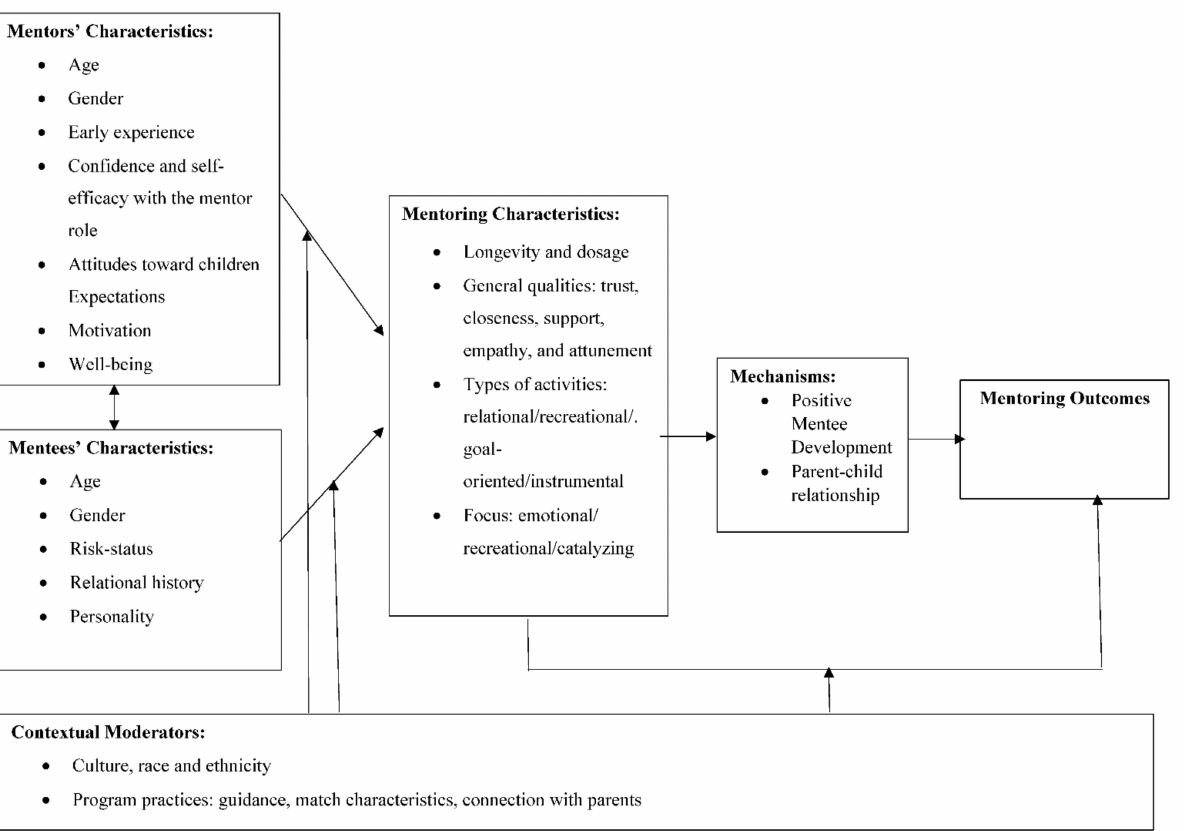
Figure 2. The determinants and mechanisms of mentoring relationship